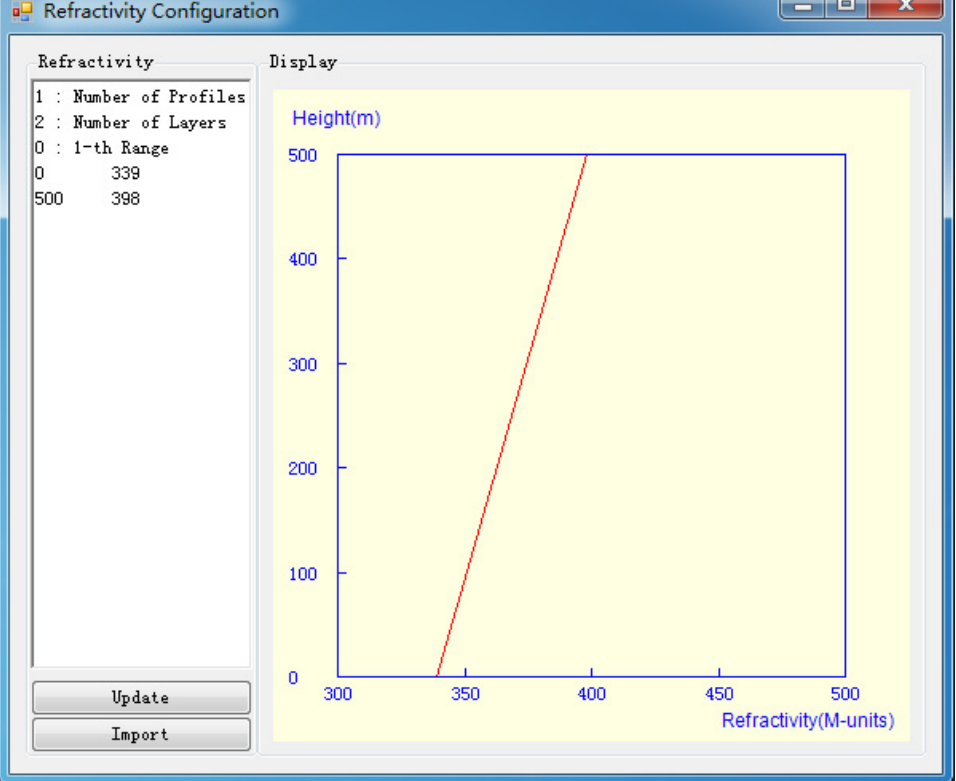
Figure 3. GUI of refractivity information.